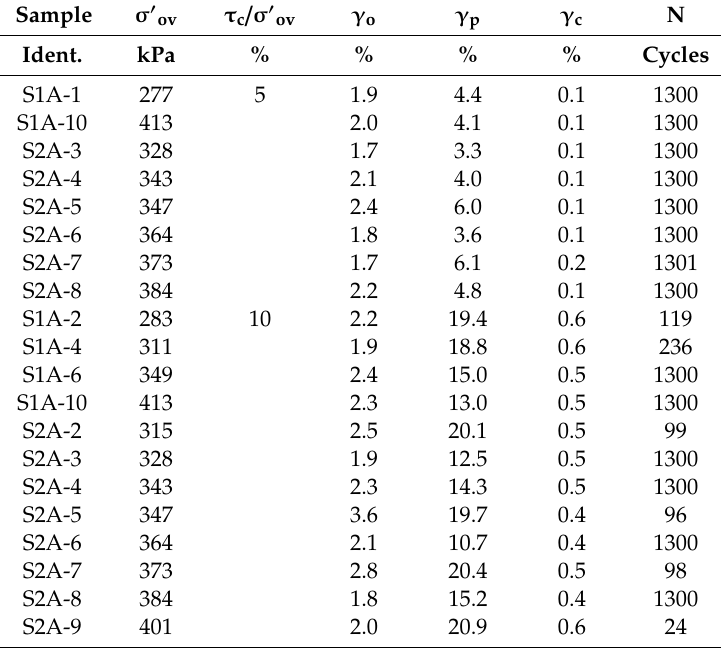
Table 8. Results of cyclic simple shear test with τ o / σ (cid:48) ov =